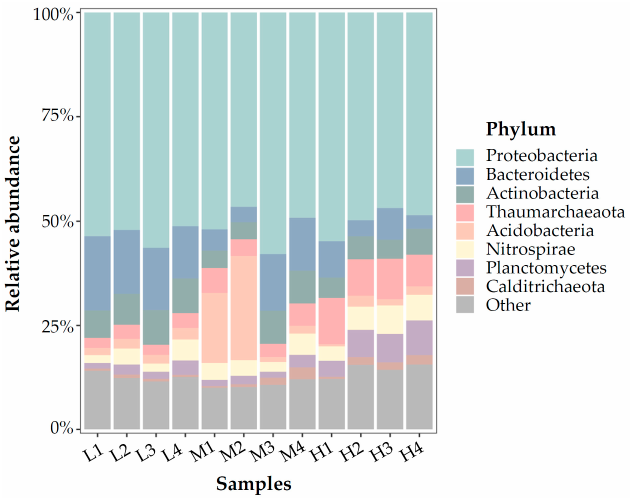
Figure 3. Taxonomic classification at the phylum level. At the family level (Figures 4 and 5), Woeseiaceae ( proteobacteria ) were the most abun- dant phylum, accounting for 9.9% to 15.5% of all reads. Besides that, Rhodobacteraceae,